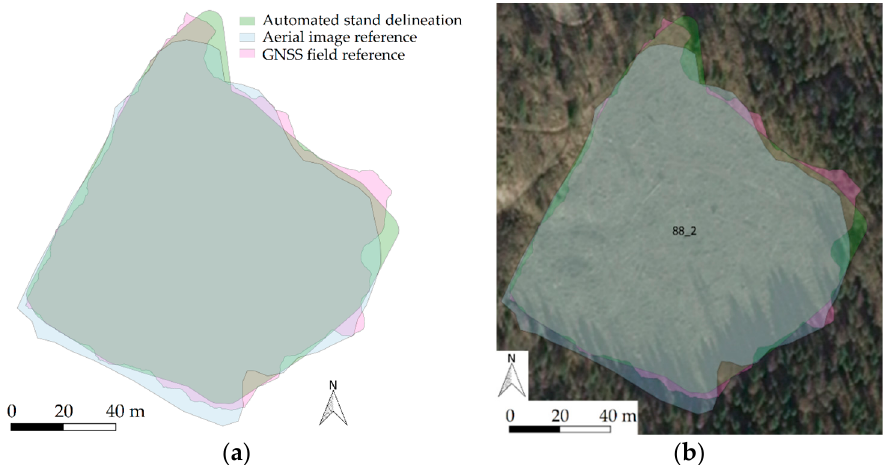
Figure 12. Example of correspondence of stand boundaries. The overall agreement is good, and agreement with GNSS reference is very good (stand is #2 of Table S1). The ETRS-TM35FIN (EPSG:3067) coordinate system is used in the figure. ( a ) The automated stand is on both reference stands. References are mutually shifted. ( b ) The aerial image is shown at the background. The harvested area is clearly visible, and the reference was digitized from the image. Aerial image © National Land Survey of Finland.